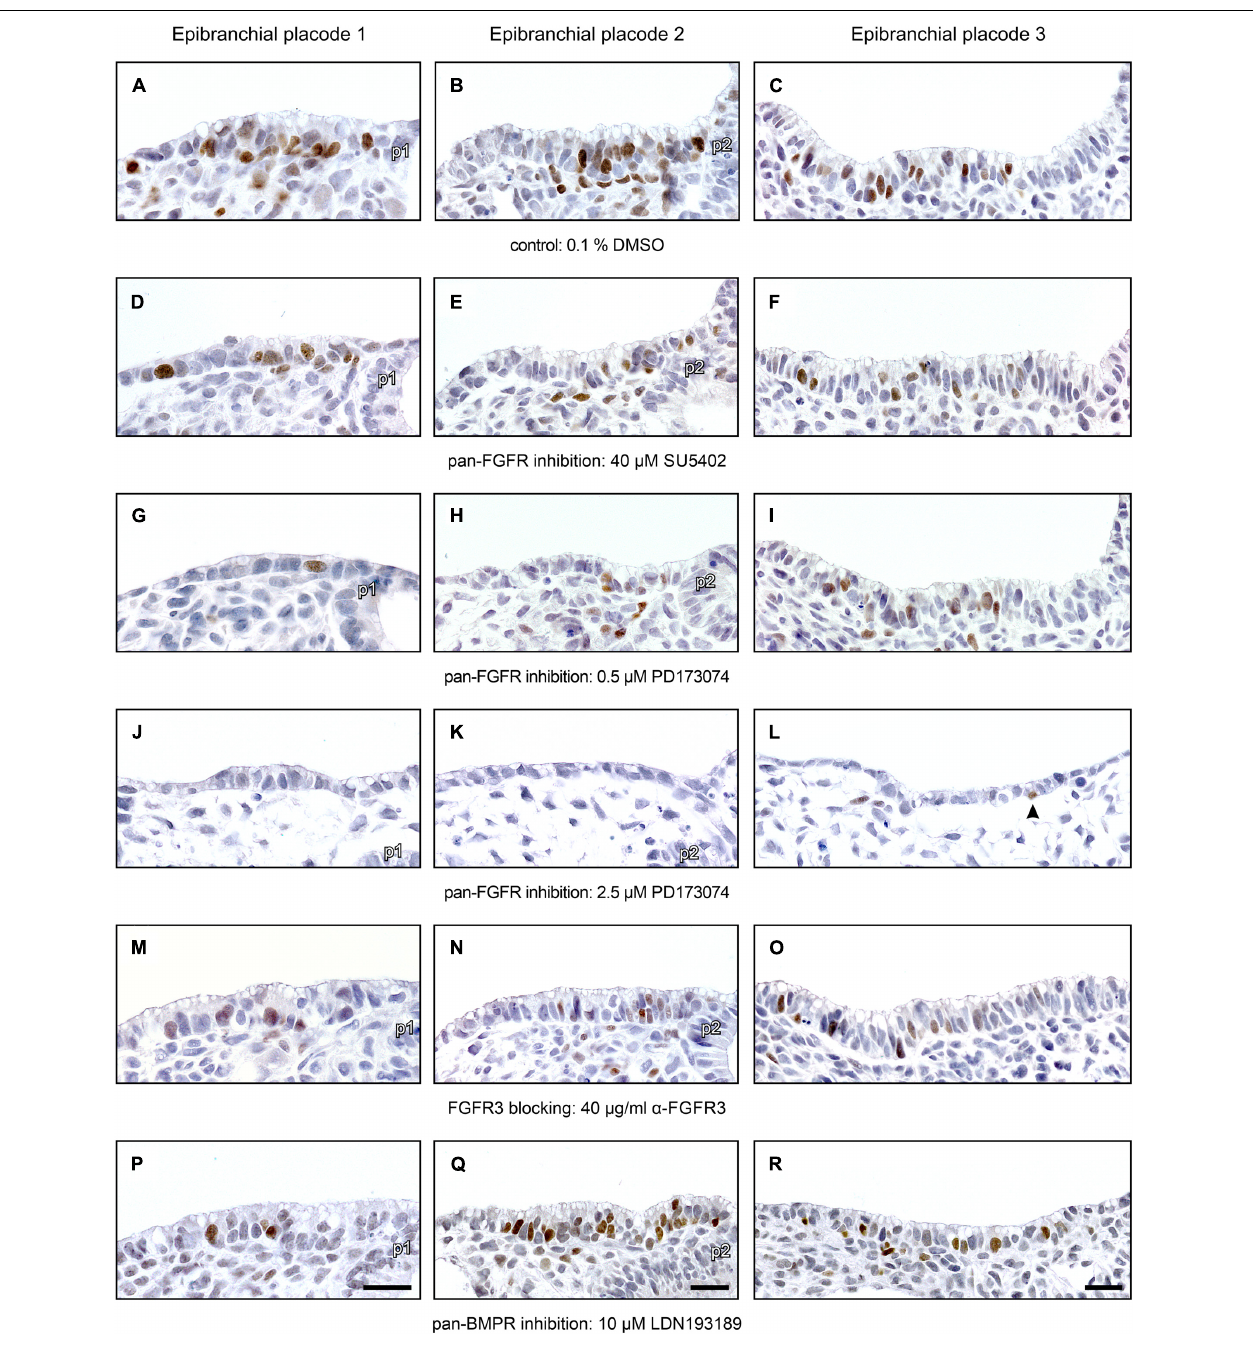
FIGURE 3 | Impact of FGFR and BMPR inhibition on epibranchial placode morphogenesis and neurogenesis in 9–14 somite mouse embryos, cultured for 24 h. Anti-Neurogenin-2 (Ngn2) immunohistochemistry (brown precipitate); shown are maximum numbers of Ngn2 + neuroblasts found per section. (A–C) Control placodes reveal high-grade thickened pseudostratified epithelium (2–4 cell nuclei) with 12–16 Ngn2 + neuroblasts. (D–F) Pan-FGFR inhibitor SU5402 (40 µ M) causes moderate reductions in placode thickness and statistically significant decreases in neuroblast numbers in the epibranchial placodes 1 and 2, but not 3 (also see Figure 4 ). (G–I) Pan-FGFR inhibitor PD173074 (0.5 µ M) elicits strong decreases in the thickness of the epibranchial placodes 1 and 2 as well as statistically significant decreases in neuroblast numbers in all three epibranchial placodes (also see Figure 4 ). (J–L) High doses of PD173074 (2.5 µ M) result in the complete absence of high-grade thickened epibranchial placodes. Only single Ngn2 + neuroblasts can be detected, if at all (arrowhead in panel L ). (M–O) Anti-FGFR3 neutralizing antibodies (40 µ g/ml) reduce Ngn2 + neuroblast numbers, but do not have negative effects on placode thickness. (P–R) Following pan-BMPR inhibition (10 µ M LDN193189), epibranchial placode 1 reveals reduced numbers of Ngn2 + neuroblasts, but normal morphology (P) ; epibranchial placode 2 lacks any obvious impairment (Q) ; epibranchial placode 3 simultaneously presents slight reductions in Ngn2 + neuroblast numbers and placode thickness (R) . p1, p2, pharyngeal pouches 1 and 2. Scale bars: 20 µ